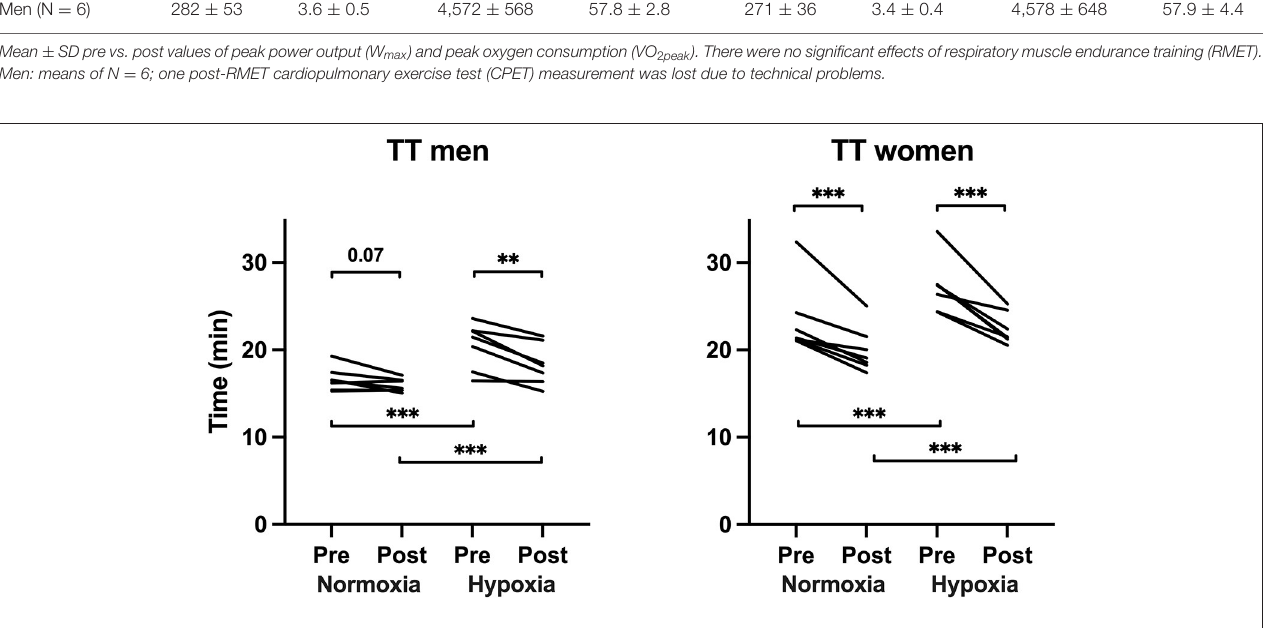
FIGURE 1 | Individual times of the 10-km time trials before and after respiratory muscle endurance training (RMET). ** p < 0.01 and *** p < 0.001. Pre–post RMET normoxia and hypoxia means were different between men and women: normoxia before RMET, p < 0.001, hypoxia before RMET, p < 0.001, normoxia after RMET, p < 0.001, and hypoxia after RMET, p < 0.05 (Sidak multiple comparison adjusted).